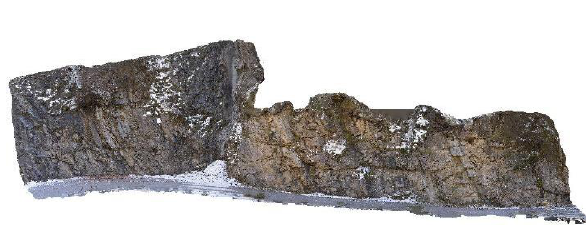
Figure 9. Example of "vertical orthophotos”.